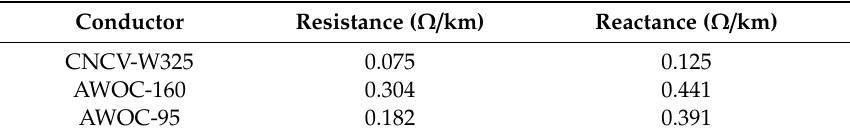
Table 1. Cable data used for the distribution